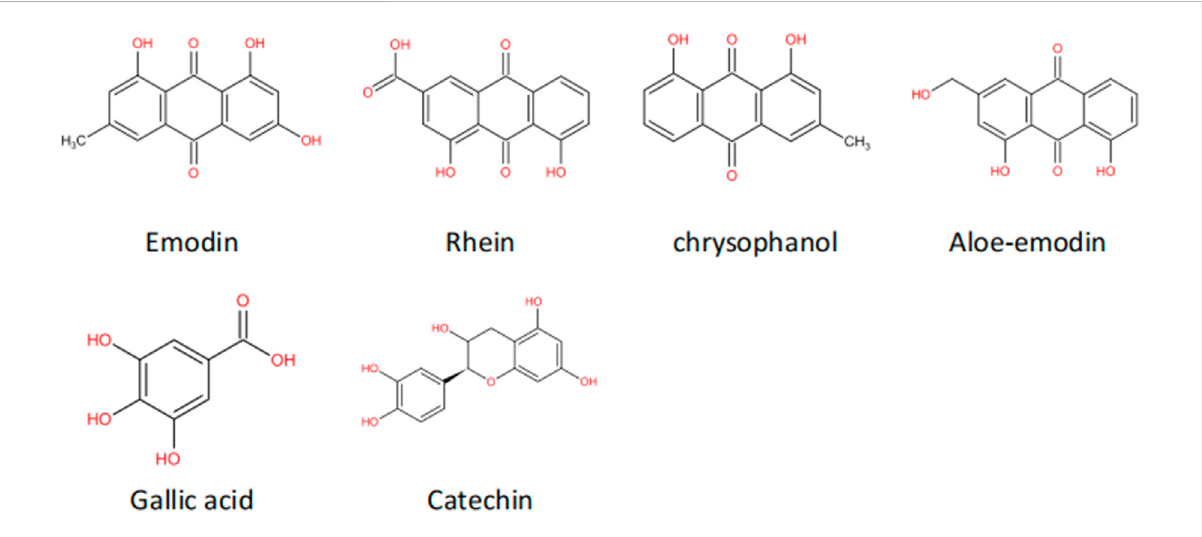
FIGURE 4 Molecular structure of natural